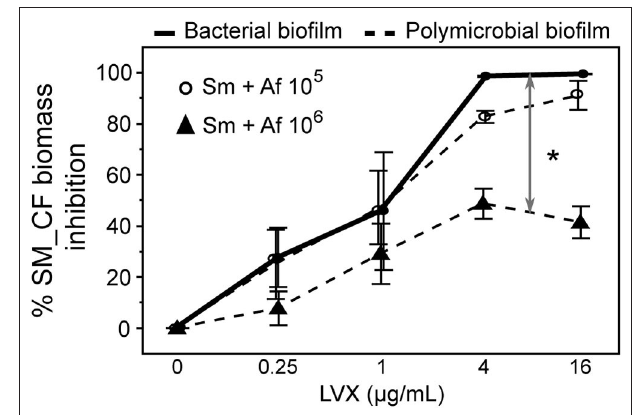
FIGURE 6 | Effects of levofloxacin on SM_CF in bacterial and polymicrobial biofilms. Susceptibility of SM_CF to LVX was assessed in bacterial (solid line) and polymicrobial biofilms (broken lines) with an initial AF_CF inoculum of 10 5 conidia/mL (circle) or 10 6 conidia/mL (triangle) by qPCR. * p < 0.05; LVX,